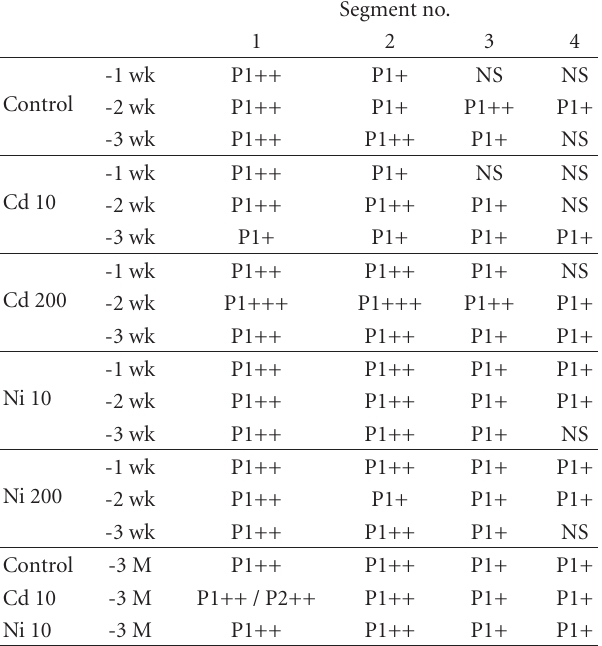
Table 2: Profiling of immunohistochemical analyses of 8-oxo-Gua accumulation in E. fetida